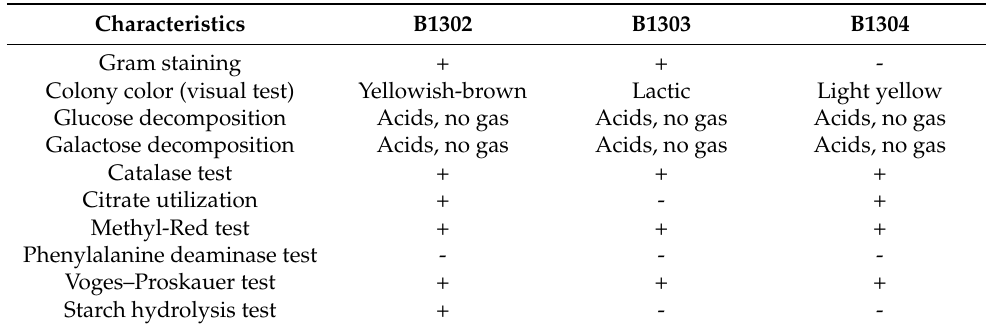
Table 3. Physiological and biochemical characteristics of the isolated bacterial